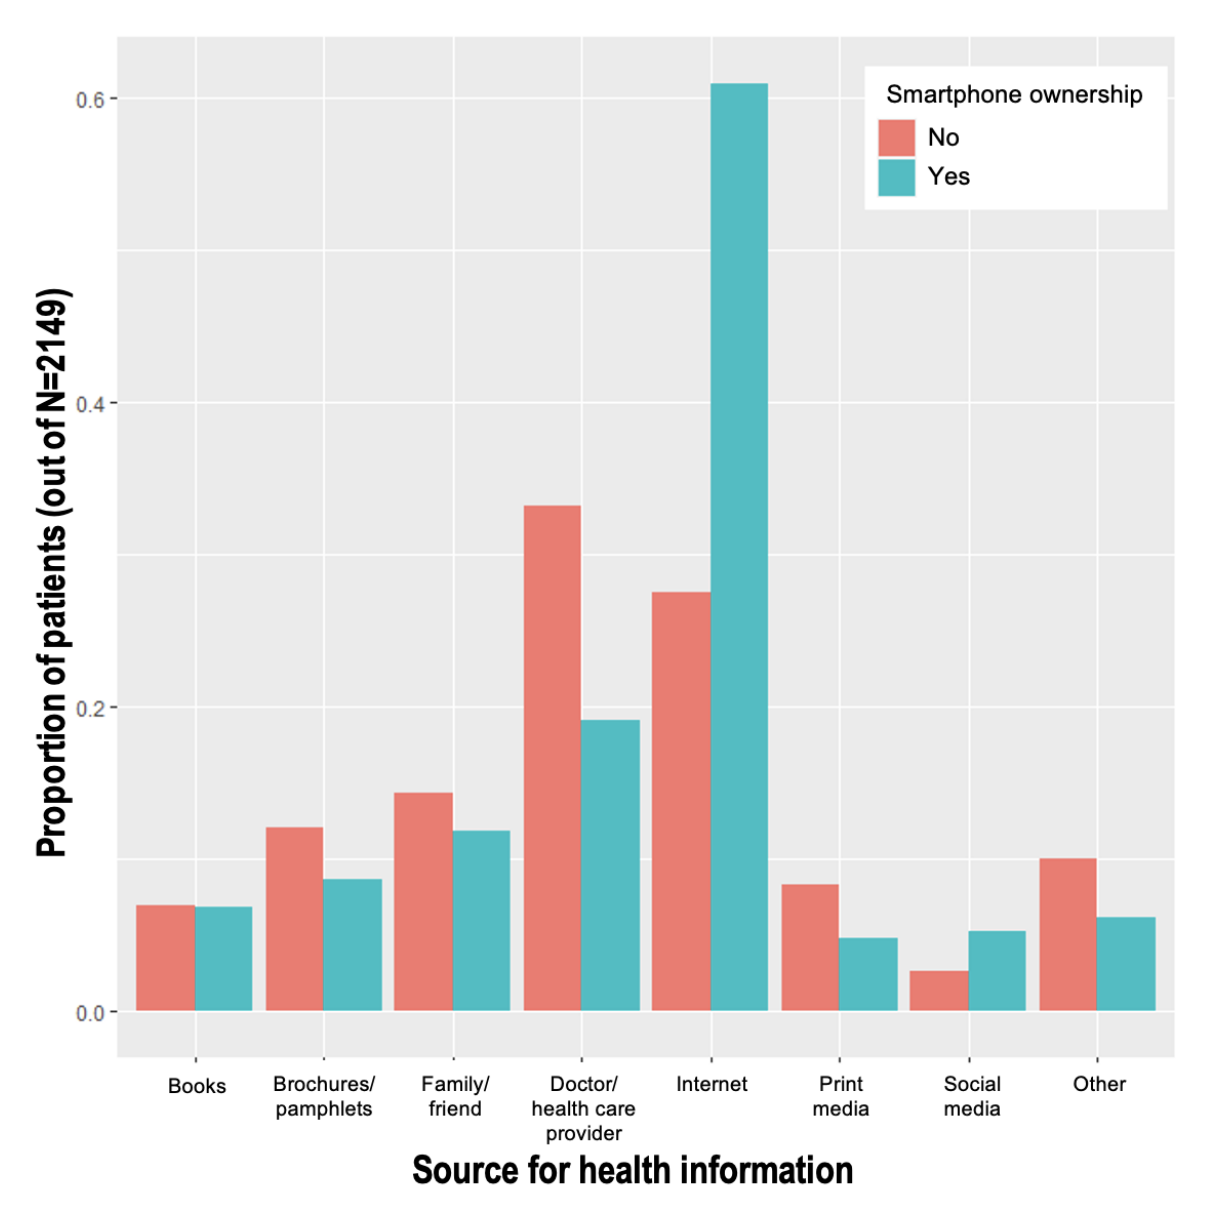
Figure 3. Source used most recently for health information by smartphone